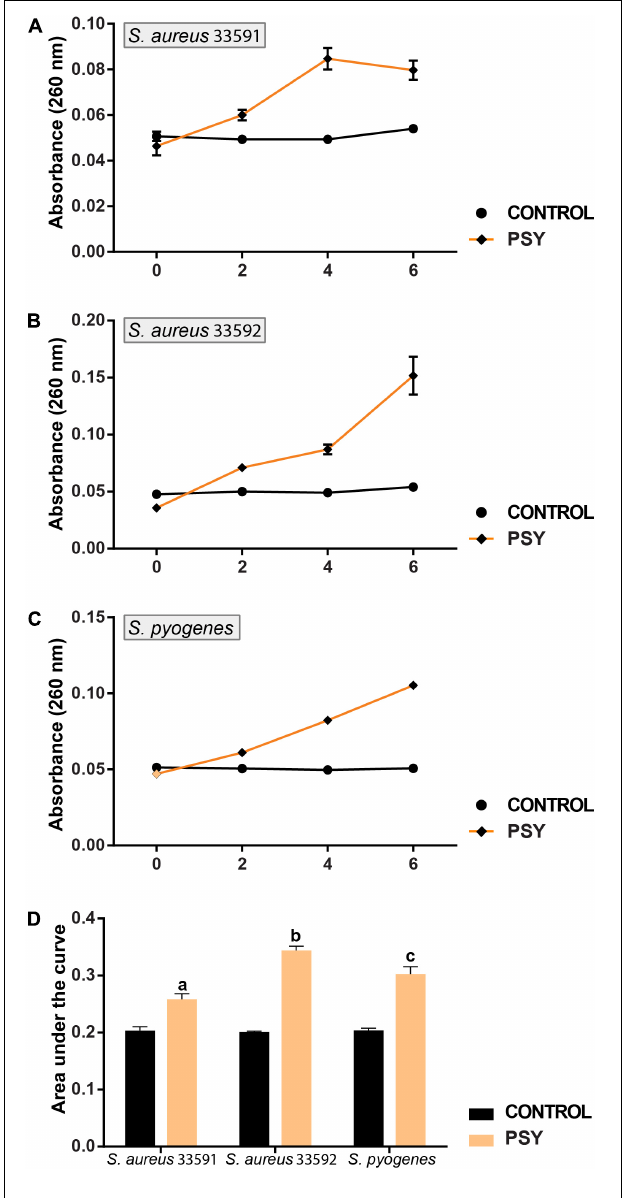
FIGURE 4 | Mode of action of psychorubrin (PSY). Effect of psychorubrin on the amount of the total nucleotide released from S. aureus 33591 (A) , S. aureus 33592 (B) , and S. pyogenes 10096 (C) . Area under the curve in PSY-treated and controls are showed in (D) . Letters indicate statistical difference from controls treated with psychorubrin vehicle for S. aureus 33591 ( a ), S. aureus 33592 ( b ), S. pyogenes 10096 ( c ) (ANOVA followed by Bonferroni, P < 0.05). All experiments were carried out in triplicate, and data represent the mean ± SD.